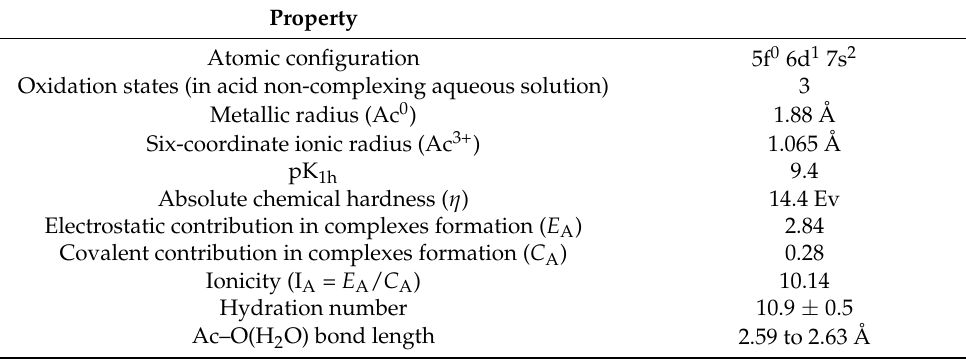
Table 1. Chemical and structural properties of the actinium nucleus and the Ac 3+ ion.